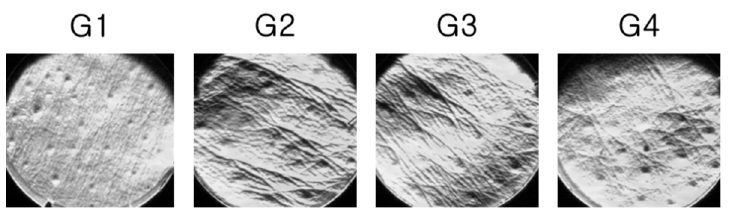
Figure 1. Photograph of the replica prepared from the dorsal skin of UVB-irradiated mice. ( G1 ), non-irradiated control group administered saline; ( G2 ), UVB-irradiated control group administered saline; ( G3) and ( G4) , UVB-irradiated test agent groups administered OBS-E at doses of 50 and 200 mg/kg BW/day, respectively.